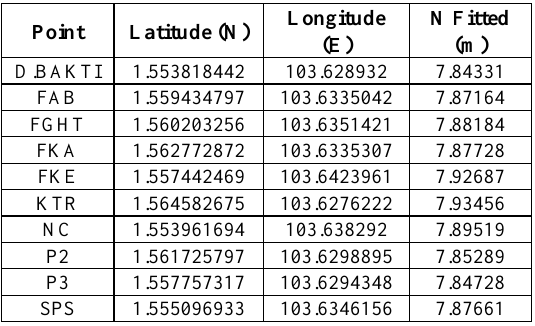
Table 8. Value of N fitted and positions at selected fitting points